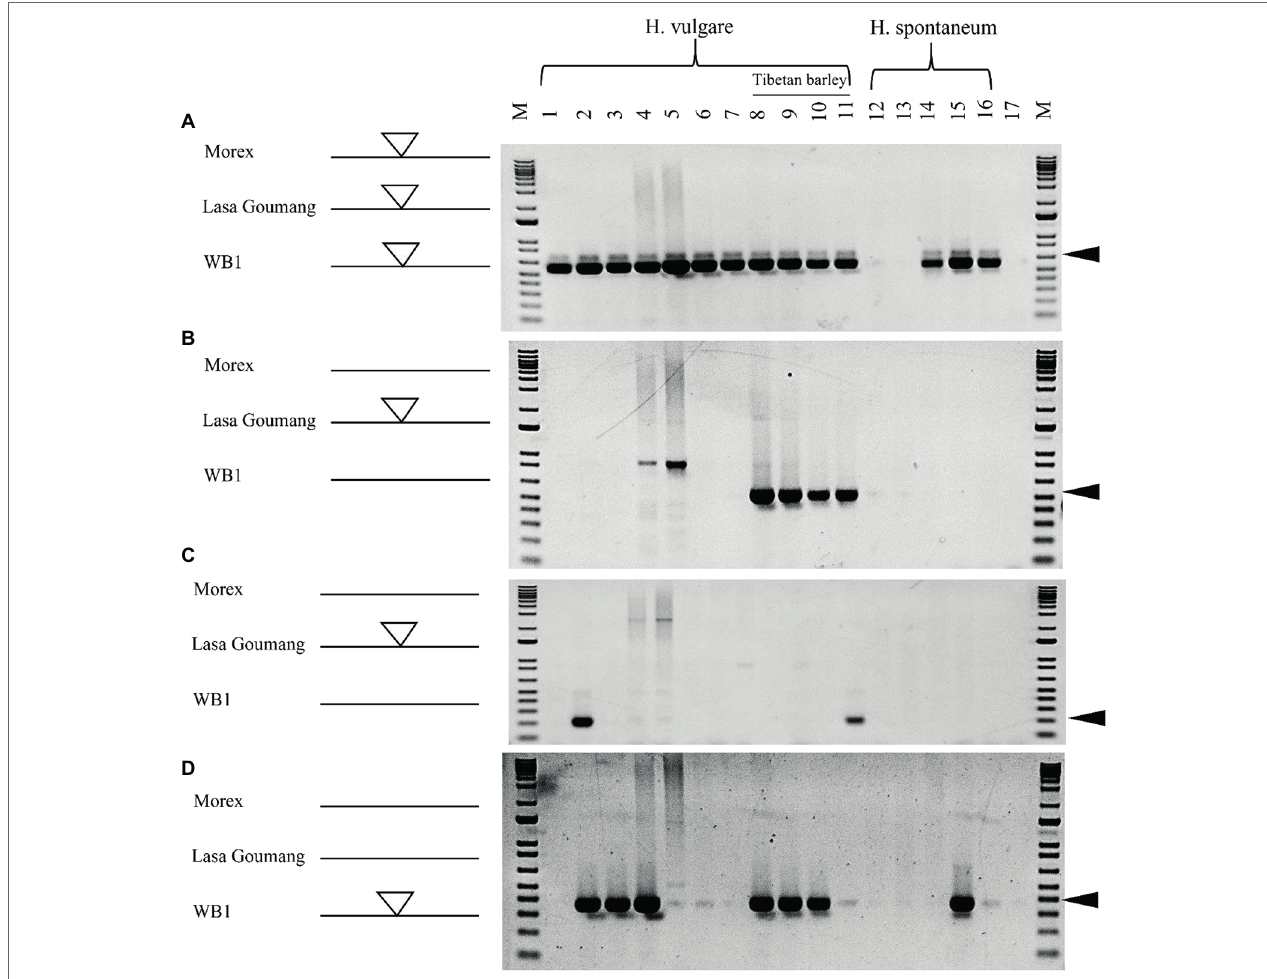
FIGURE 7 | PCR analysis of 16 barley genotypes using the primers of UAAB5 (A) , UAAB11 (B) , UAAB13 (C) , and UAAB7 (D) . M means the 1-Kb plus DNA ladder. One to eleven represent 11 cultivated barley genotypes, 1: Morex; 2: Akashinriki; 3: Igri; 4: HOR_3081(Slaski); 5: Golden Promise; 6: Hockett; 7: AAC Synergy; 8: Qingki; 9: Tibetan (PI 506343); 10: Tibetan (PI 195542); 11: Tibetan (CIho 3,087), and the 12–16 indicated five wild barley accessions, 12: PI 282572; 13: PI 282574; 14: PI 282575; 15: PI 282588 and 16: PI 282593. Seventeen is a negative control and no DNA template was added for PCR amplification. The white and bigger triangles represent the inserted transposons in the left side, and the black and smaller triangles in the right side mean the expected sizes of